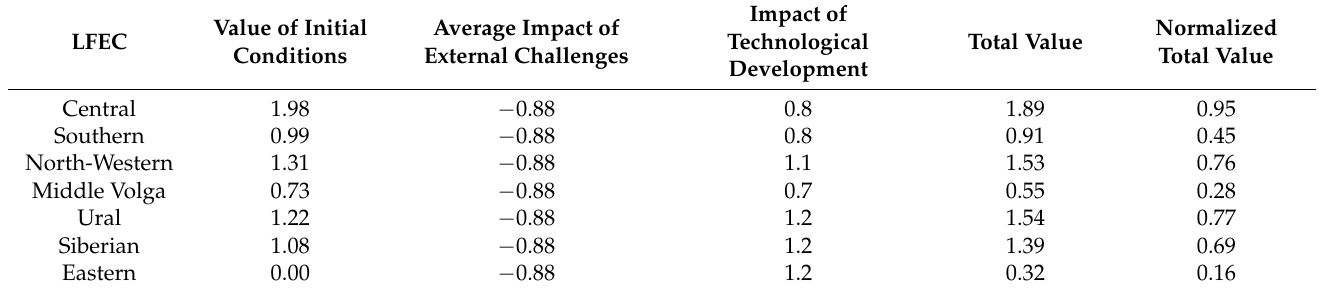
Table 6. Primary data and coefficient of sustainability (T 1 ) for the gas industry for the neutral scenario in the period